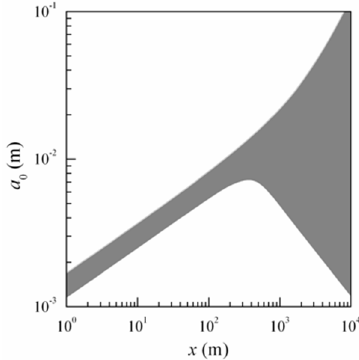
Figure 2. The nomogram for choosing the initial laser beam radii 0 a .